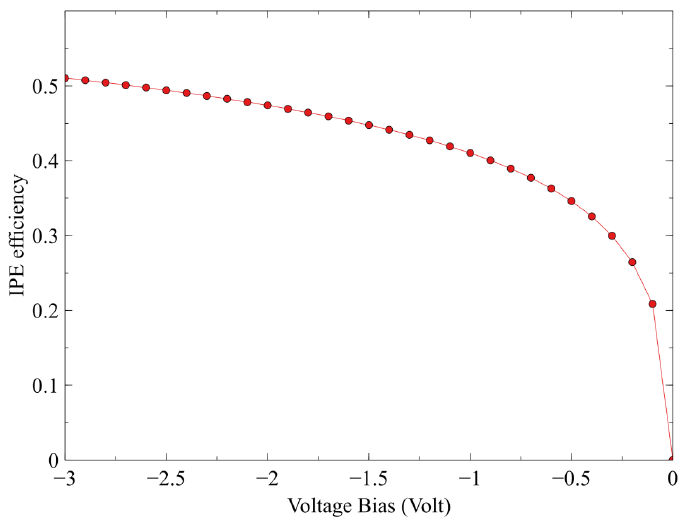
Figure 7. IPE effect efficiency (η IPE ) for 20 nm chromium thin film for 850 nm light source.